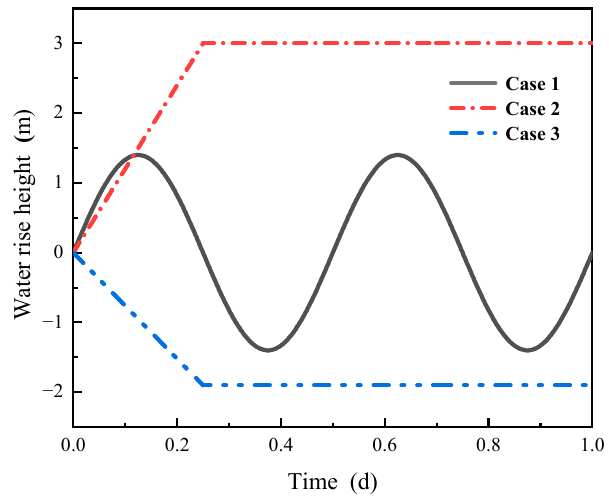
Figure 4. Time-varying curves of water-level changes under three cases.